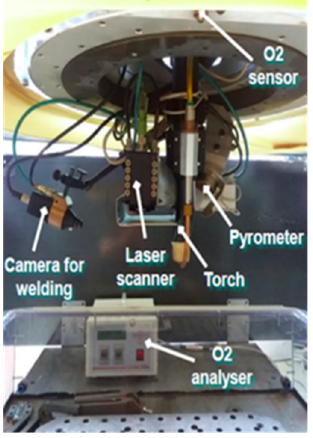
Figure 2. Sensors installed in the machine head.